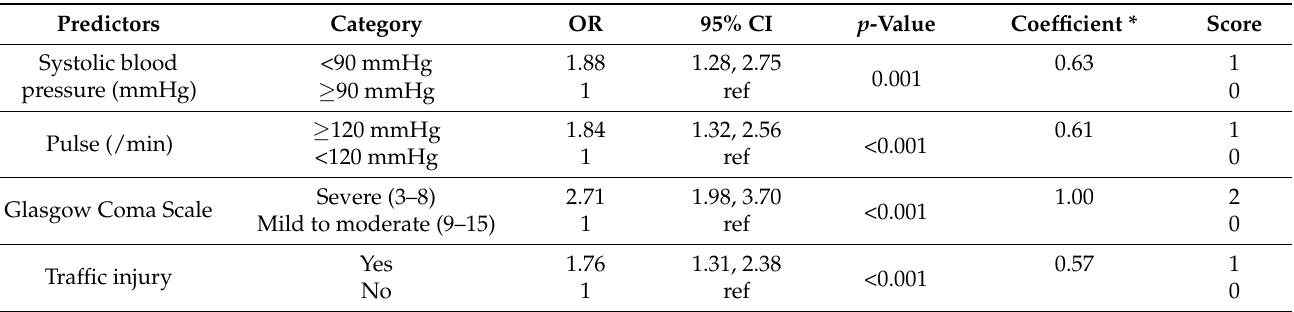
Table 2. Significant predictors of the three time bands of death (dead ≤ 8 h, dead 8–24 h, alive at 24 h) and assigned item score.